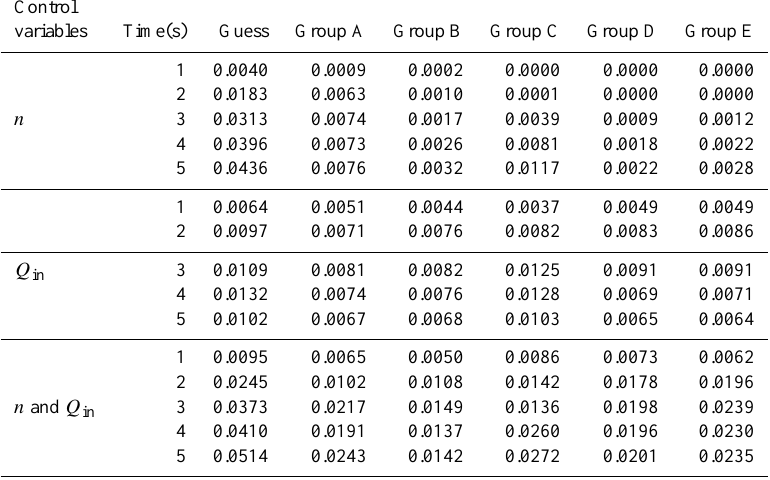
Table 3. The RMS errors of water depth at t = 1, 2, 3, 4, and 5s in experiment series A, B, and C. Control